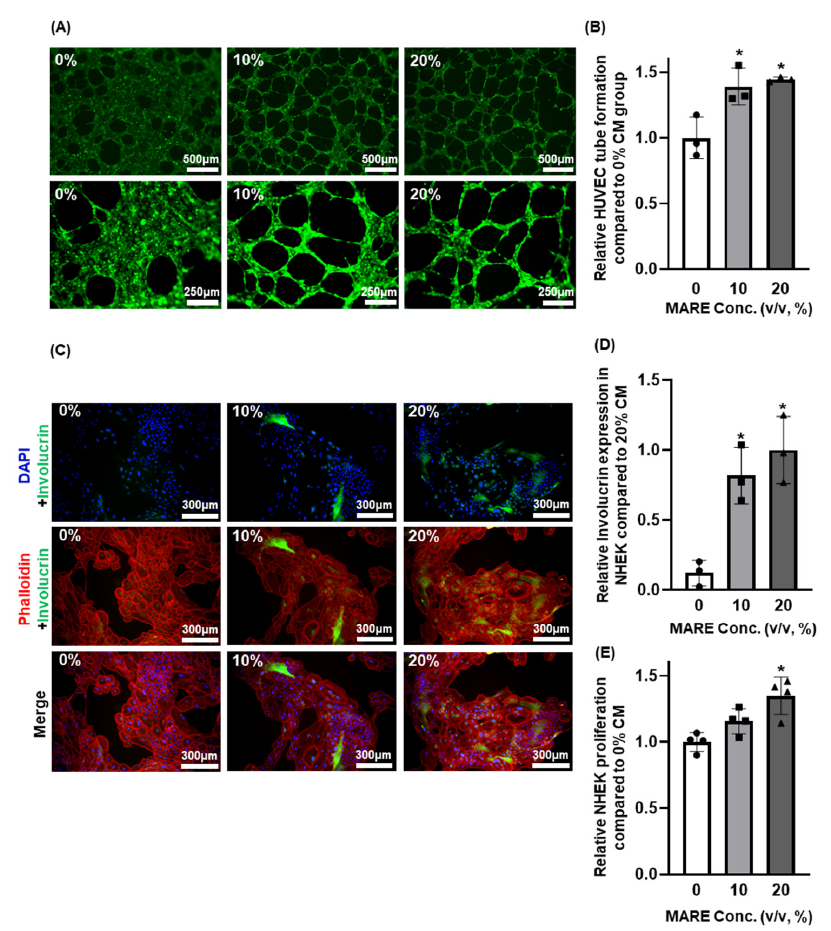
Figure 6. Effect of conditioned media (CM) retrieved from MARE-treated HFDPCs on human umbilical vein endothelial cells (HUVECs) and normal human epithelial keratinocytes (NHEKs). ( A ) Tubular formation of HUVECs observed at 5 h after CM treatment. ( B ) Quantification of the tube formation in HUVEC compared to the 0% group ( n = 3, * p < 0.05 compared to the 0% group, one-way ANOVA test). ( C ) Immunocytochemistry (ICC) of involucrin (green) in NHEK merged with DAPI (nucleus, blue) and phalloidin (F-actin, red). ( D ) Relative data of involucrin expression (* p < 0.05 compared to the 0% group, one-way ANOVA test). ( E ) Proliferation of NHEKs 3 d after CM treatment ( n = 4, * p < 0.05 compared to the 0%